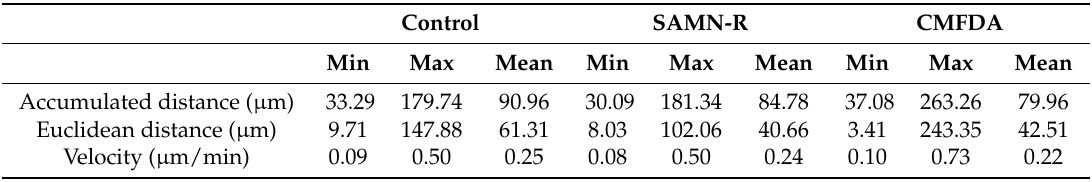
Table 6. Migration of hMSCs in Patient 4 from 50 cells of control, CMFDA-labelled, and SAMN-R treatment groups. The velocity, accumulated, and Euclidean distance values for a six-hour period are shown.